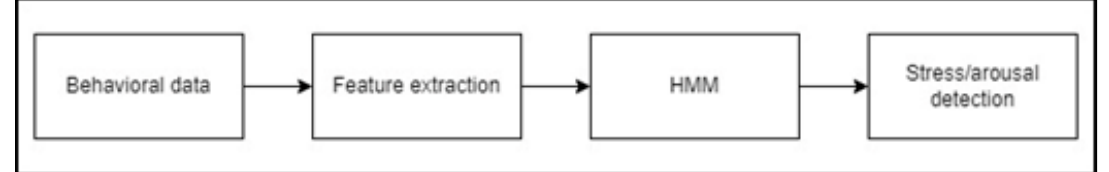
Figure 6. Work fl ow of the behavioural data